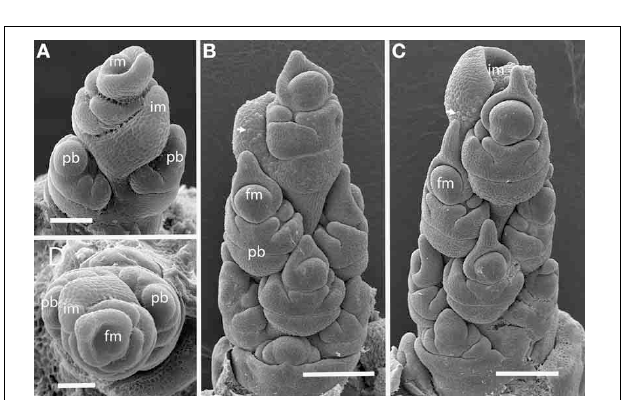
FIGURE 1 | Outgroups. (A–C) Aphelia brizula , showing distichous phyllotaxis. (A) entire plant; (B) inflorescence with bracts removed; (C) close-up of the apex of (B) ; arrow indicates one of four visible gynoecia. The apex terminates in a set of increasingly small gynoecia that appear to lack bracts. (D,E) Centrolepis aristata , showing spiral phyllotaxis. (D) Dotted lines